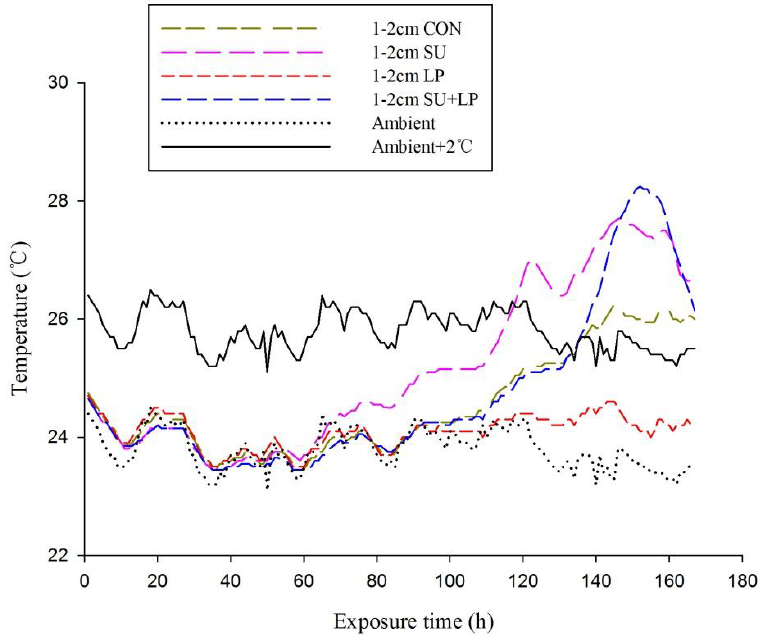
Figure 1. The temperature changes of L. chinensis silage at a length of 1–2 cm with the time of aerobic exposure. CON, control; SU, sucrose; LP, Lactobacillus plantarum.